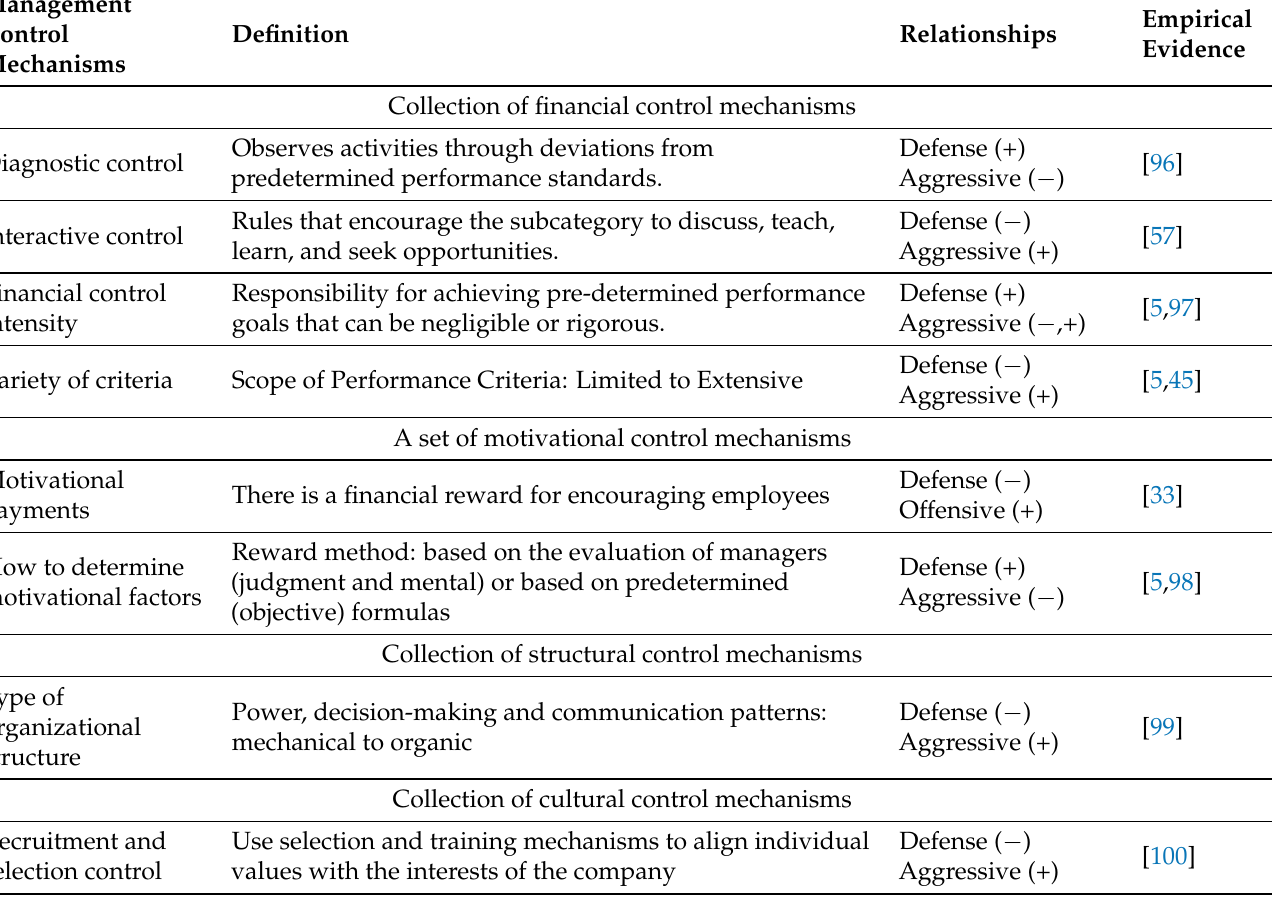
Table 2. Definitions of management control system and summary of empirical